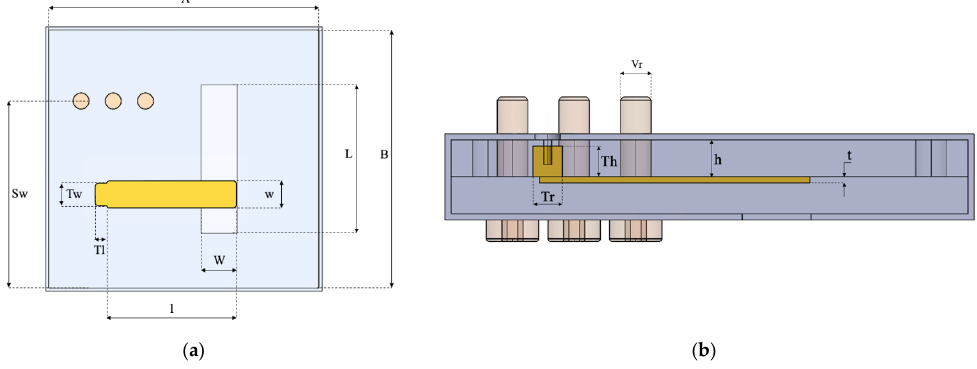
Figure 3. ( a ) Top cut view of the antenna assembly with the widths and lengths of each component; ( b ) Lateral cut view of the antenna assembly with the heights and diameters of the components.